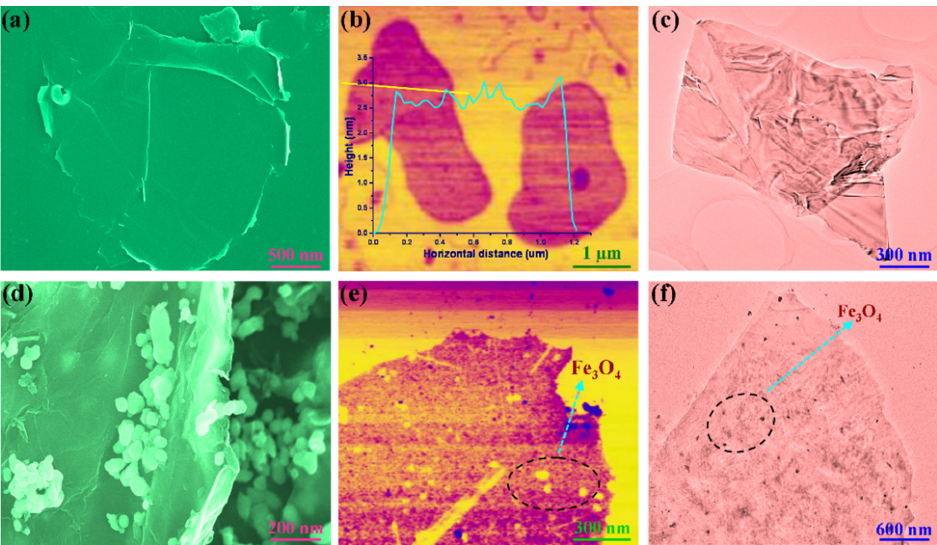
Figure 2. ( a ) SEM, ( b ) AFM, and ( c ) TEM images of pristine graphene nanosheets. ( d ) SEM, ( e ) AFM, and ( f ) TEM images of graphene/Fe 3 O 4 hybrid.